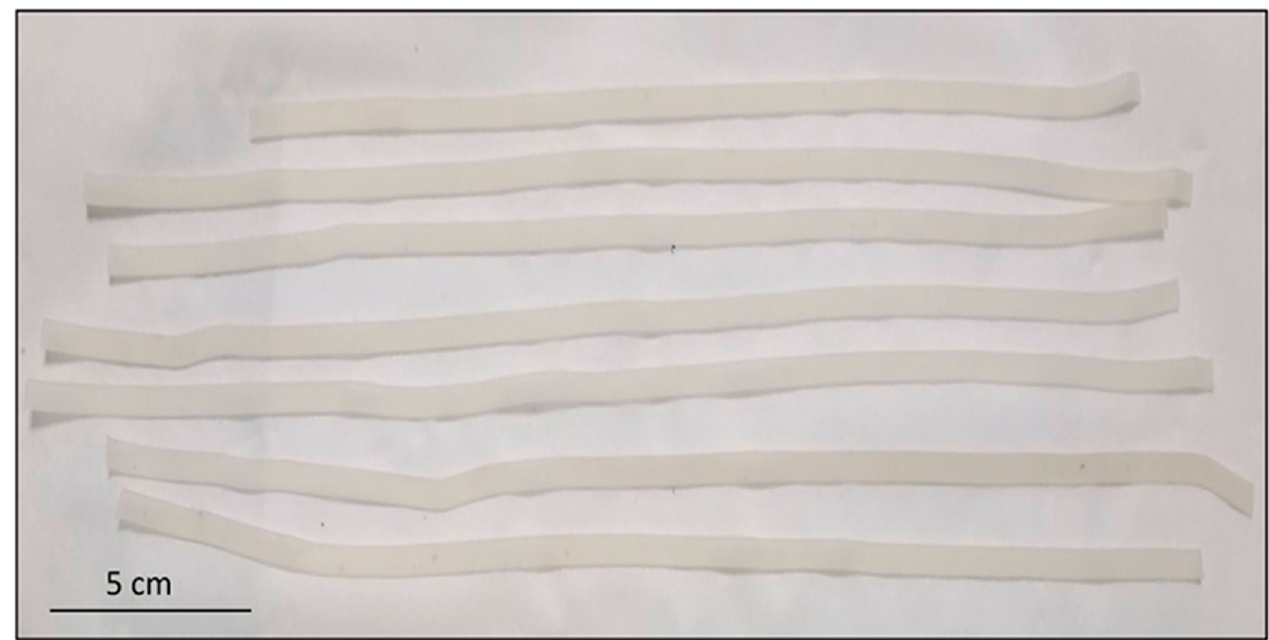
Figure 1. Picture showing the extruded stripes of the batch containing 50%wt of API and 5%wt of Guar gum. Scale bar 5 cm.